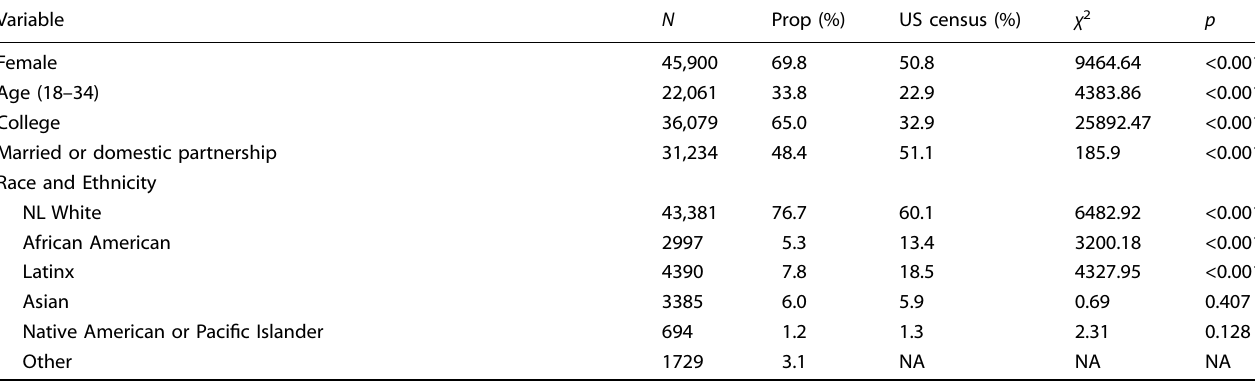
Table 1. Proportion of HMP users versus US census